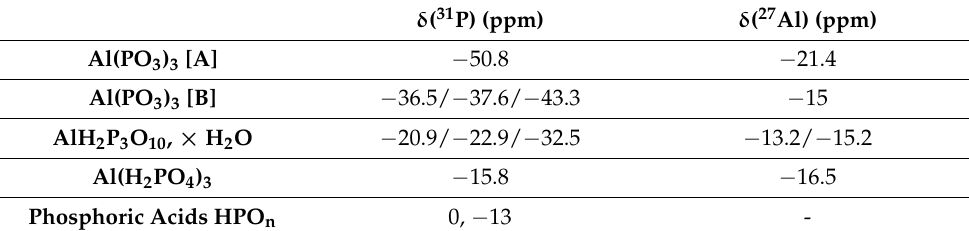
Table 2. 31 P and 27 Al NMR chemical shift values of the Al 2 O 3 -P 2 O 5 -H 2 O compounds observed during the thermal evolution of the P/Al = 3 solution (from